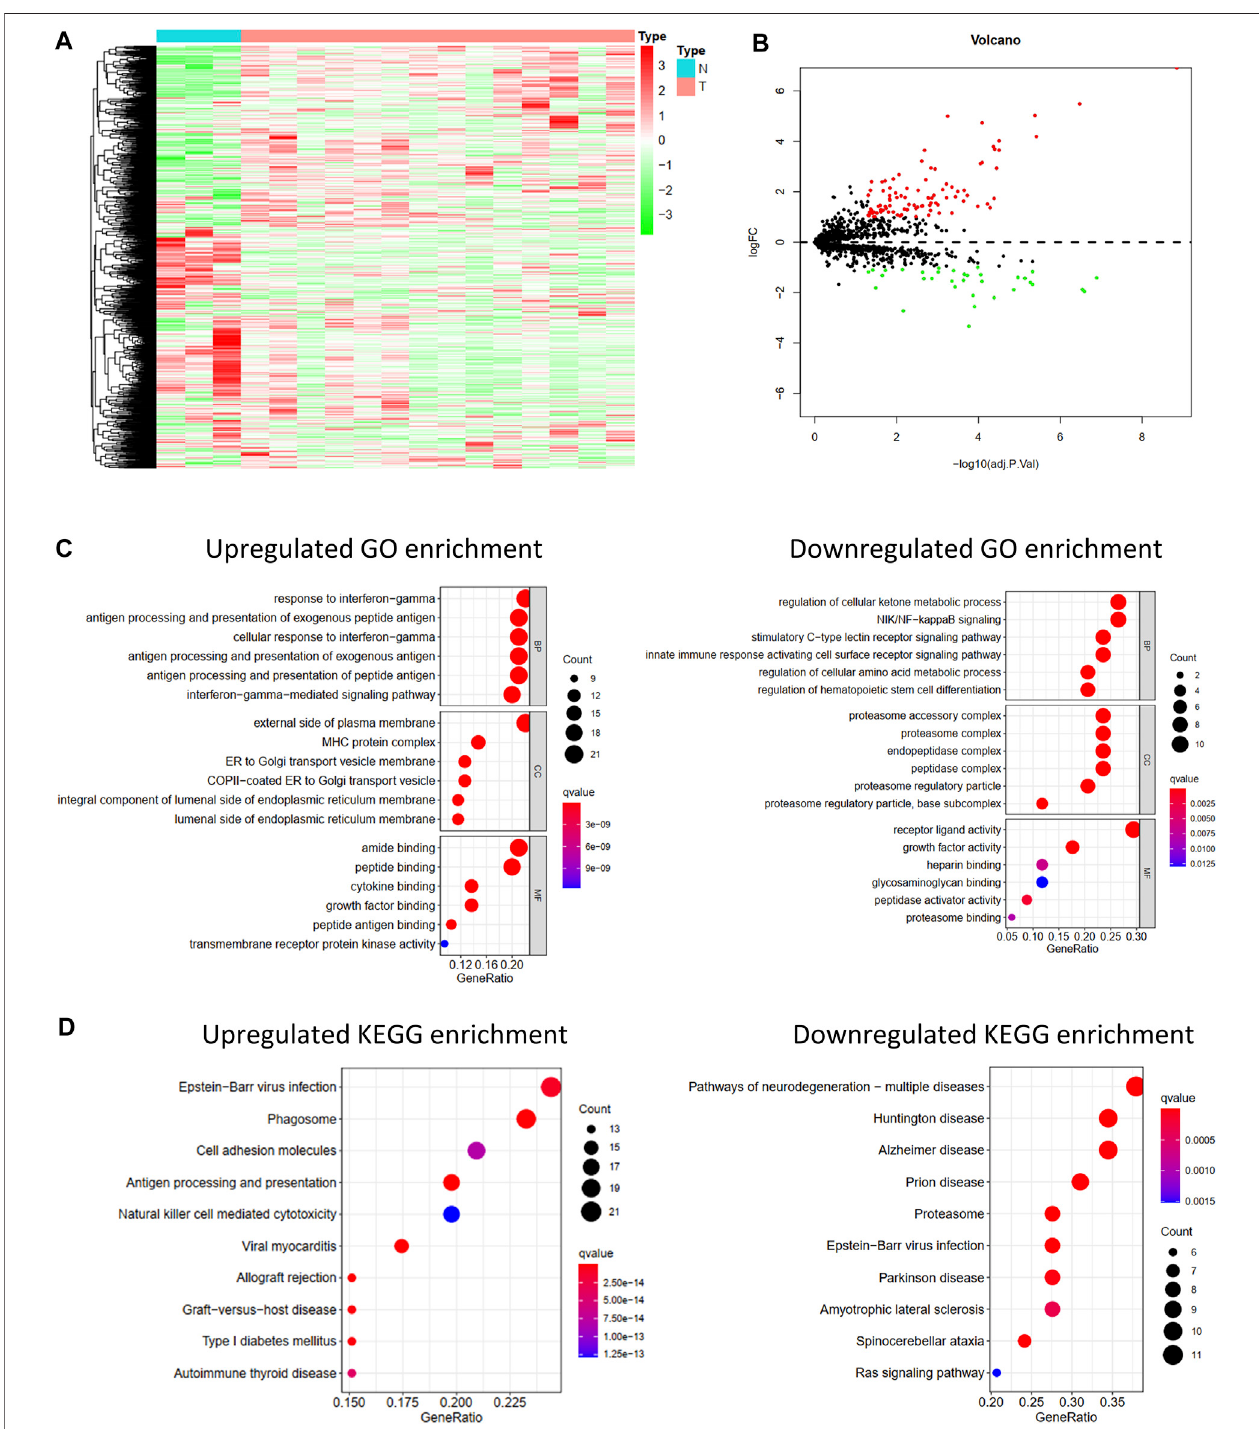
FIGURE 1 | Differentially expressed IRGs and its function enrichment analysis. Heatmap (A) and volcano plot (B) of 1,793 immune-related genes in normal bone tissues and osteosarcoma tissues from GSE16088. (C) GO pathway enrichment of upregulated and downregulated IRGs. (D) KEGG pathway enrichment of upregulated and downregulated